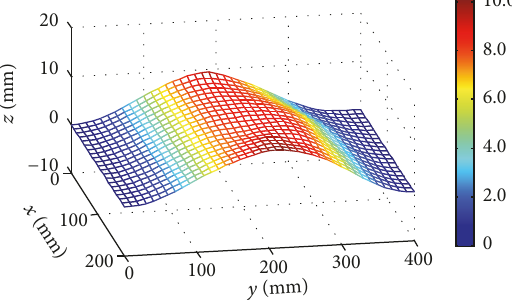
Figure 15: Controlled shape under optimal